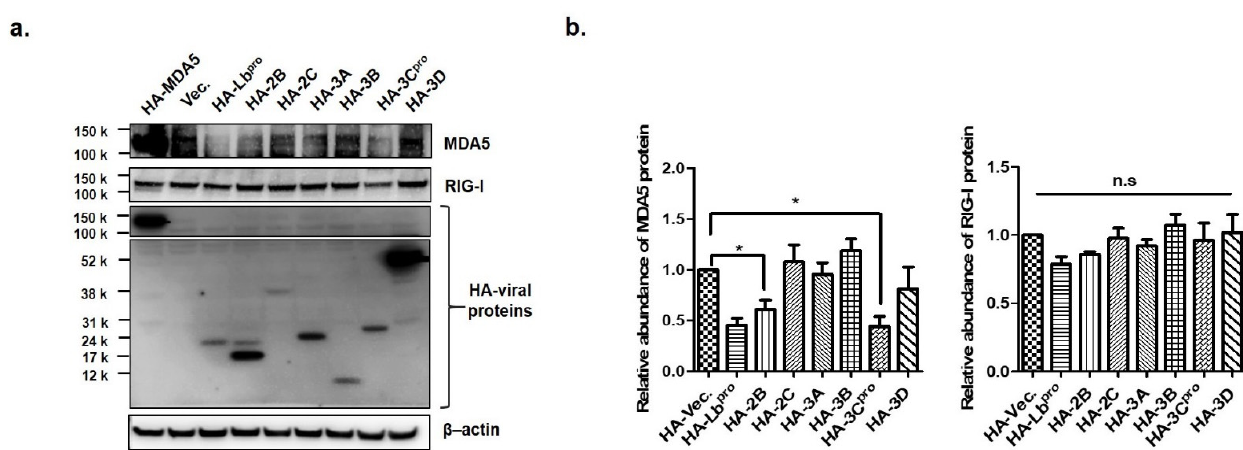
Figure 2. The effects of Lb pro and 3C pro on endogenous MDA5 protein expression. ( a ) HEK293T cells (1 × 10 6 cells) were transfected with HA (Hemagglutinin)-tagged proteins plasmids (MDA5, Lb, 2B, 2C, 3A, 3B, 3C or 3D) or empty HA-vector plasmid at the amount of 2 µg. Cells were lysed 16 h later and analyzed by Western blotting with anti-HA, MDA5, RIG-I and β -actin antibodies. ( b ) The abundance of MDA5 and RIG-1 proteins were calculated by Image J software to quantify the band intensity, normalized to β -actin and respectively compared with the group of HA-vector. The result is shown of one of the triplicate experiments, presented as mean ± SEM (*, p < 0.05 and n.s., not significant).